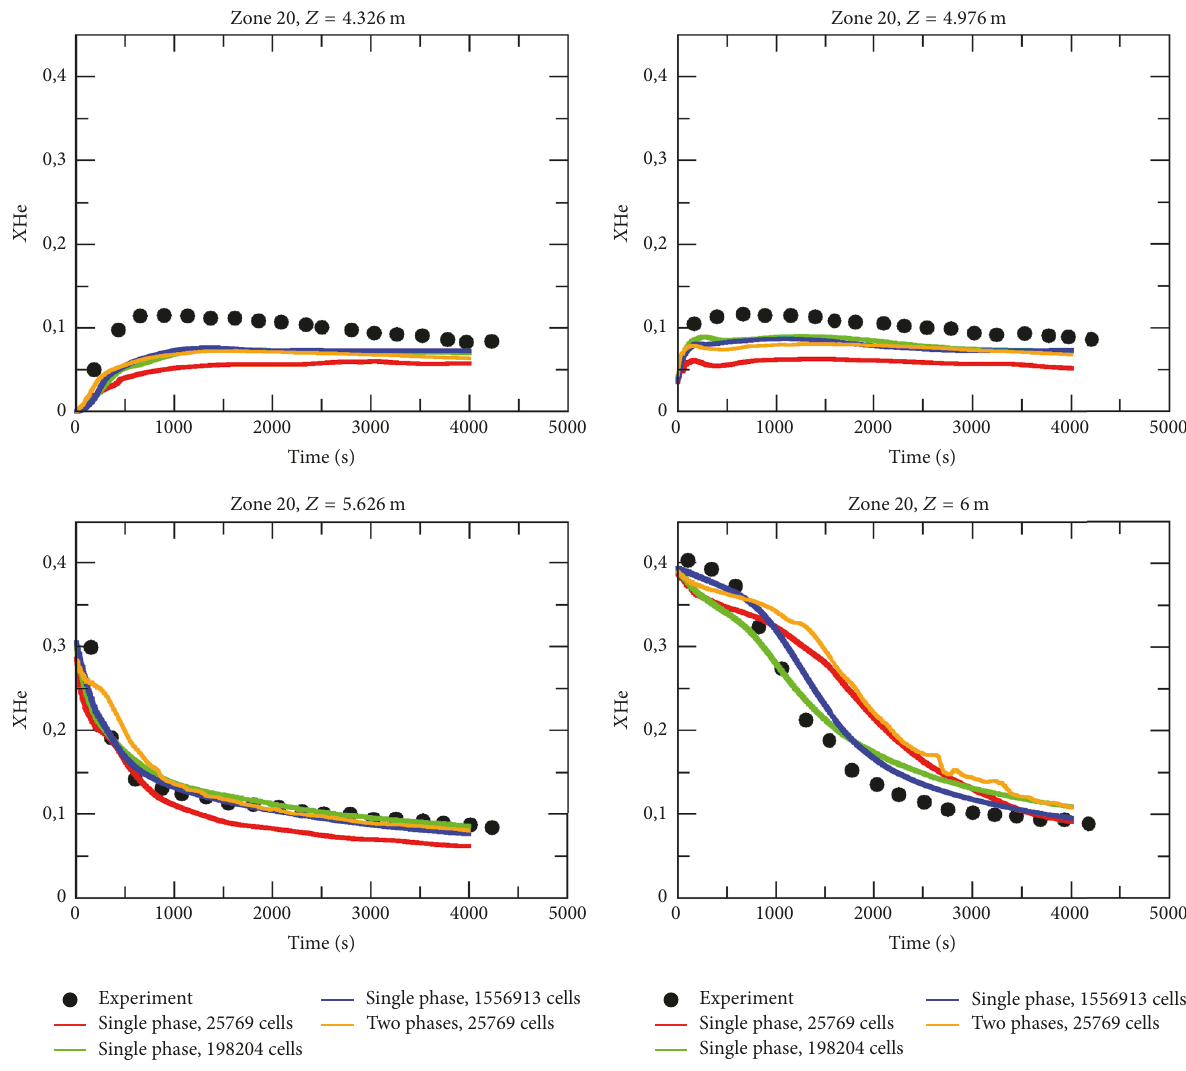
Figure 6: Helium concentration along the time for probes on zone 20 in PANDA ST1 7; “single phase” stands for Code Saturne and “two phases” stands for NEPTUNE CFD code.